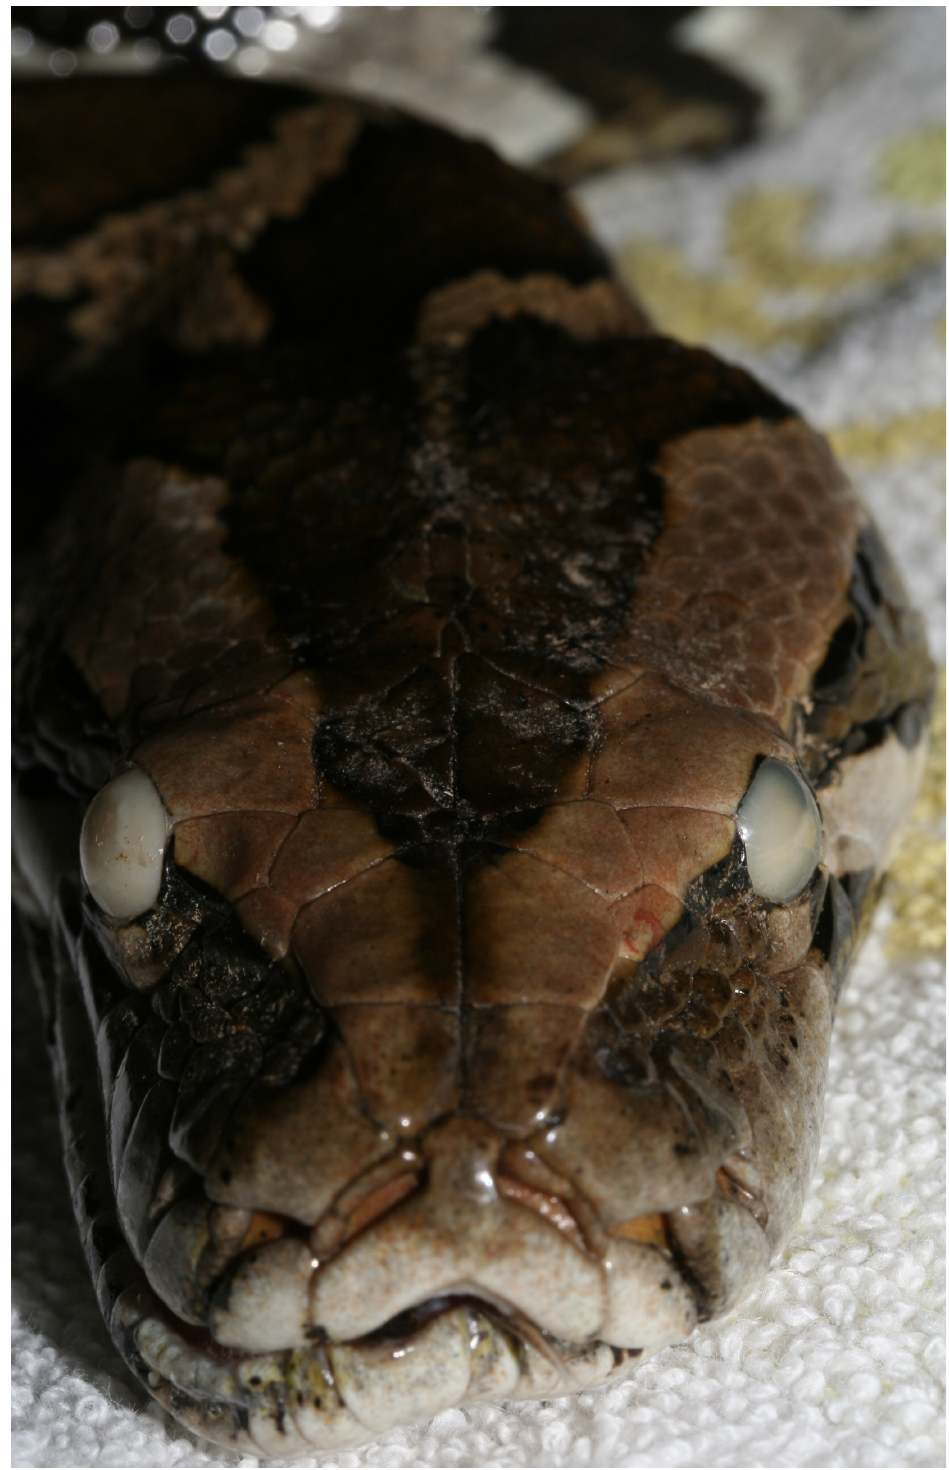
Figure 32. Bilateral subspectacular abscesses as seen in this Burmese python ( Python bivittatus ) is a relatively unusual presentation and should warrant the inclusion of possible systemic bacterial infection as a primary etiology.